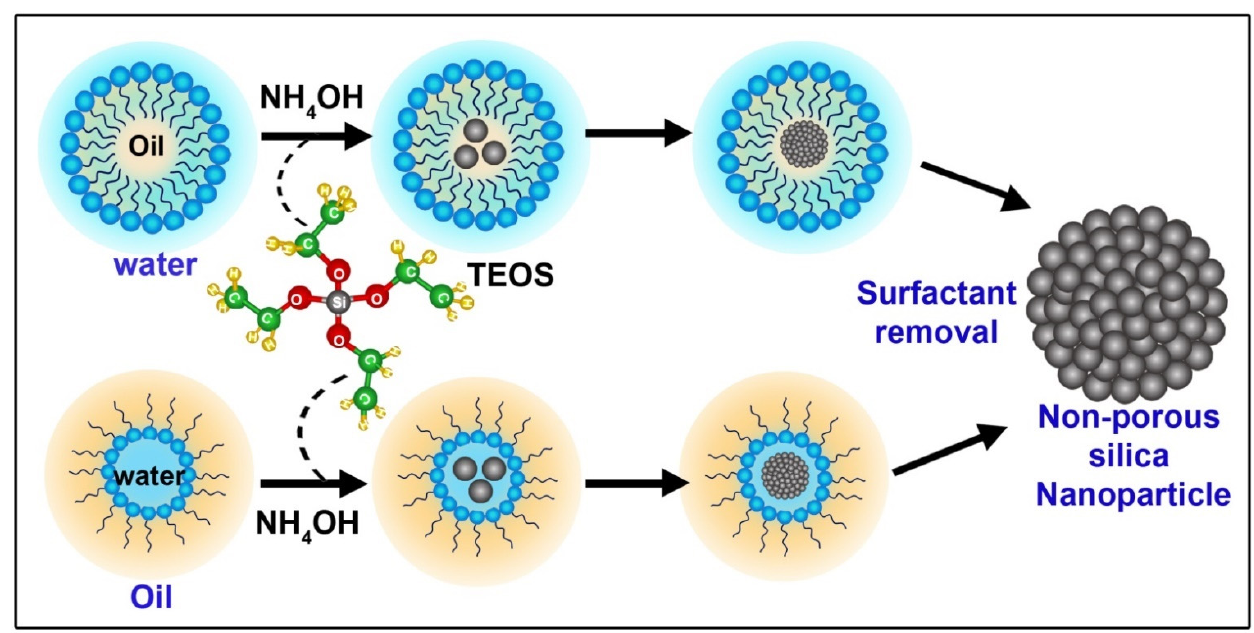
Figure 1. Schematic diagram representing microemulsion method for the synthesis of silica nanoparticles (SNPs).